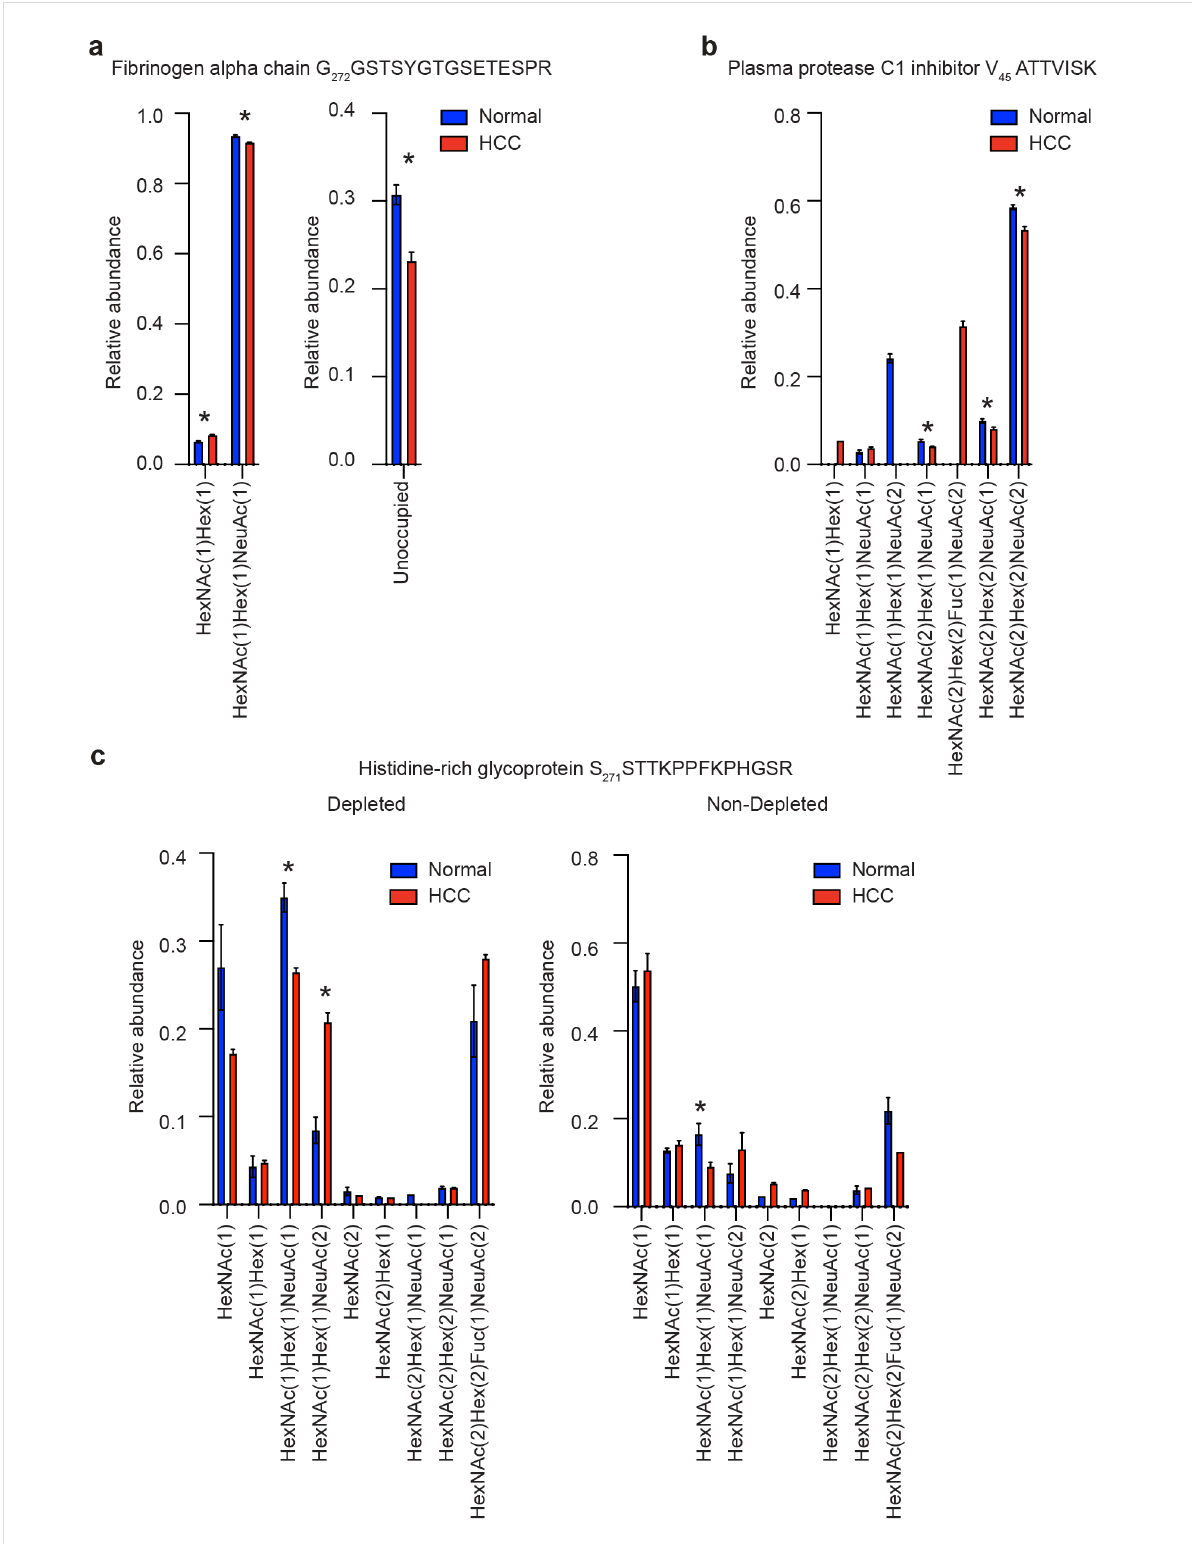
Figure 5: Peptide-specific O -glycosylation profiling with GlypNirO. Peptide-specific relative glycoform abundance in HCC patients and healthy controls on (a) fibrinogen alpha chain G 272 GSTSYGTGSETESPR, (b) plasma protease C1 inhibitor V 45 AATVISK, and (c) histidine-rich glycoprotein S 271 STTKPPFKPHGSR. N = 3; values show mean; error bars show standard error of the mean; *, P <